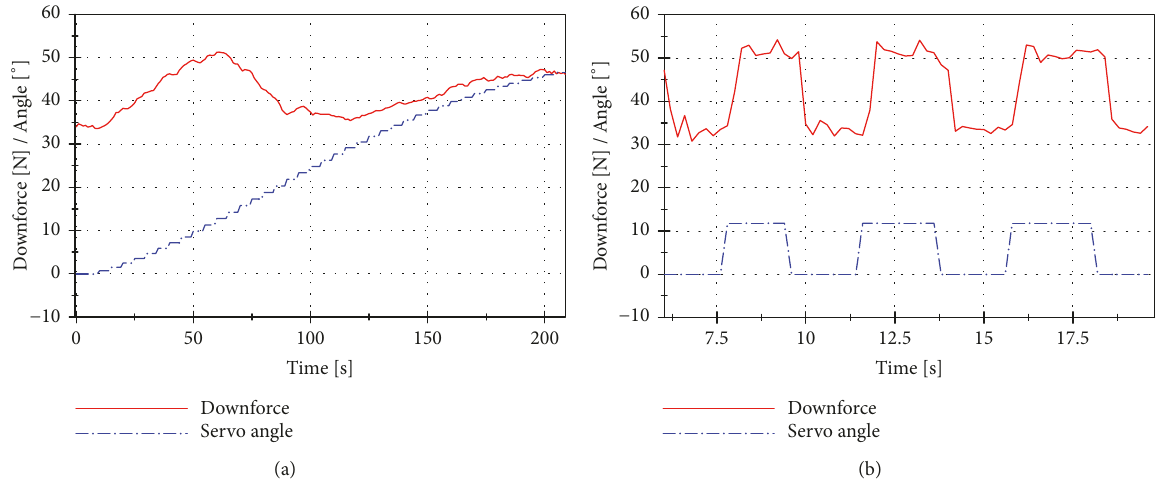
Figure 6: Characteristics of the downforce and the servo angle for (a) a slow movement of the wing and (b) quick changes of the wing’s placement from -5 ∘ up to 50 ∘